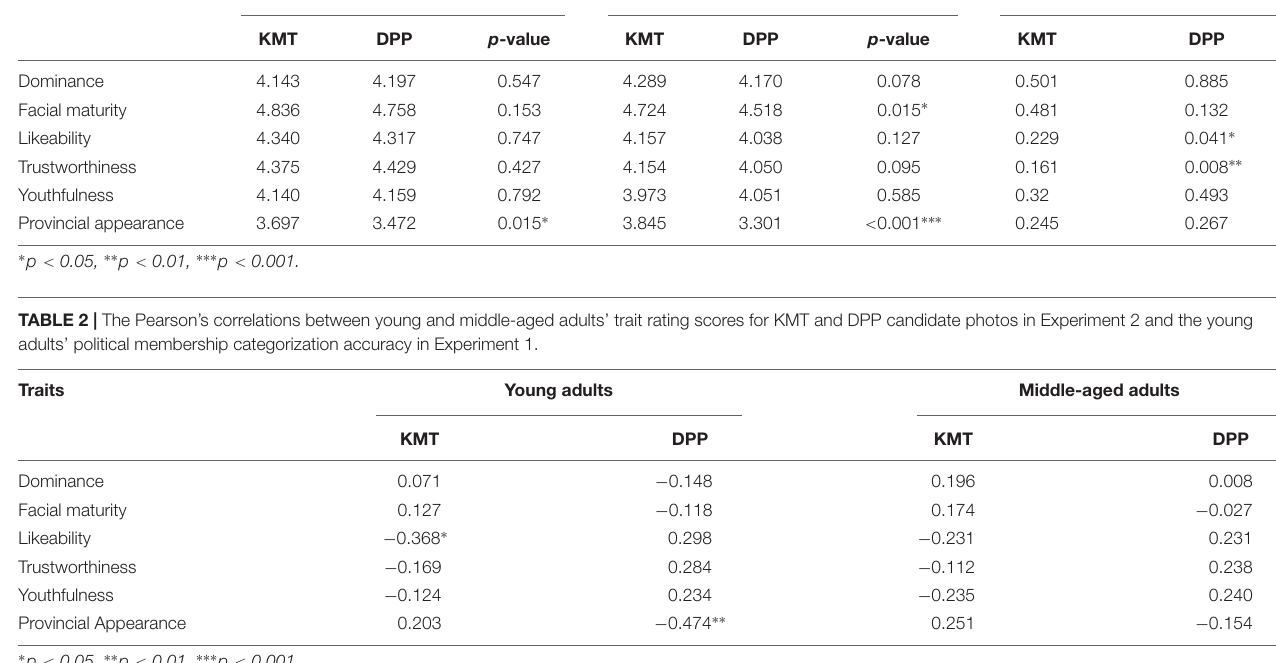
age groups ( p -value)